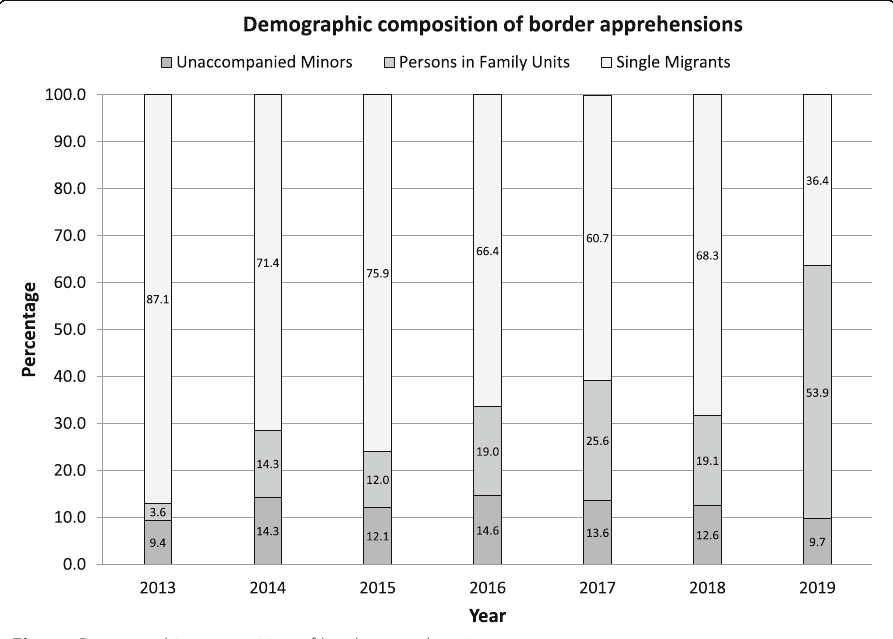
Fig. 14 Demographic composition of border